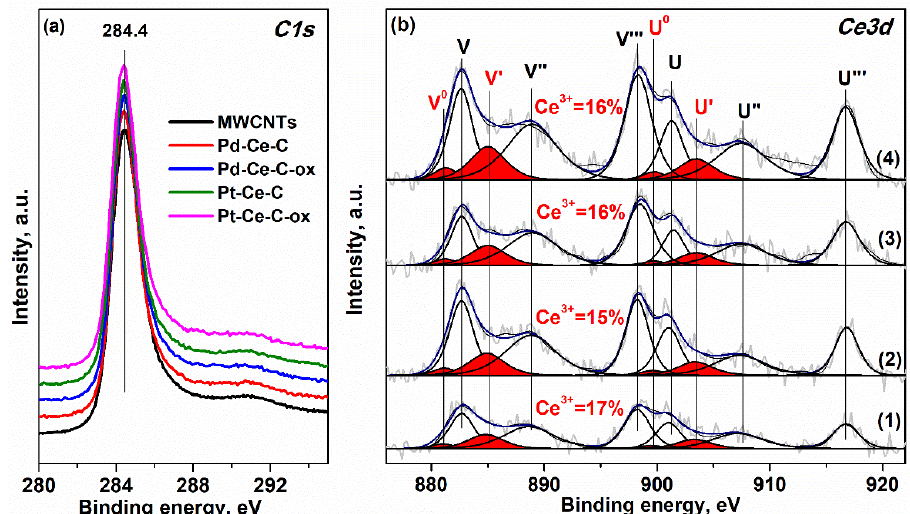
Figure A3. ( a ) The C1s spectra of the samples. ( b ) The Ce3d spectra for the Pd-based and Pt-based samples: (1) Pd-Ce-C, (2) Pd-Ce-C-ox, (3) Pt-Ce-C, (4) Pt-Ce-C-ox. The V 0 ,V’ and U 0 , U’ peaks corresponded to the Ce 3+ species marked with red color. Grey lines correspond to the experimental spectra.